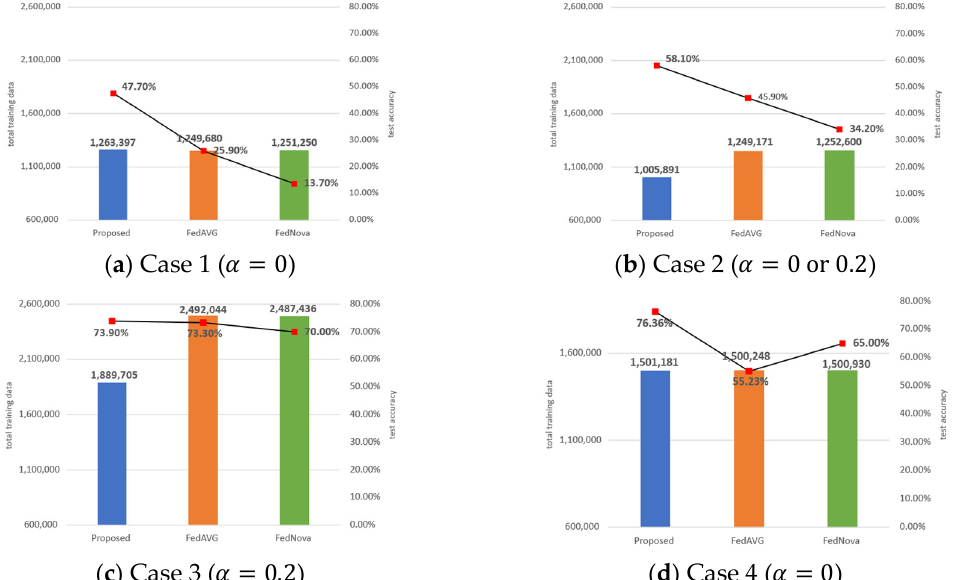
Figure 7. Amount of training data (bar graph) and accuracy (red dot) comparison among the proposed algorithm, FedAVG, and FedNova on different non-IID situations. Cases 1–3 are the results of the CIFAR-10 dataset, and Case 4 is the result of the MNIST dataset.